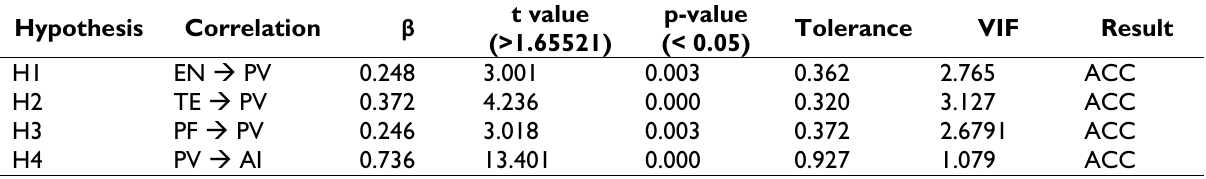
Table 5. Hypothesis Test Results (Path